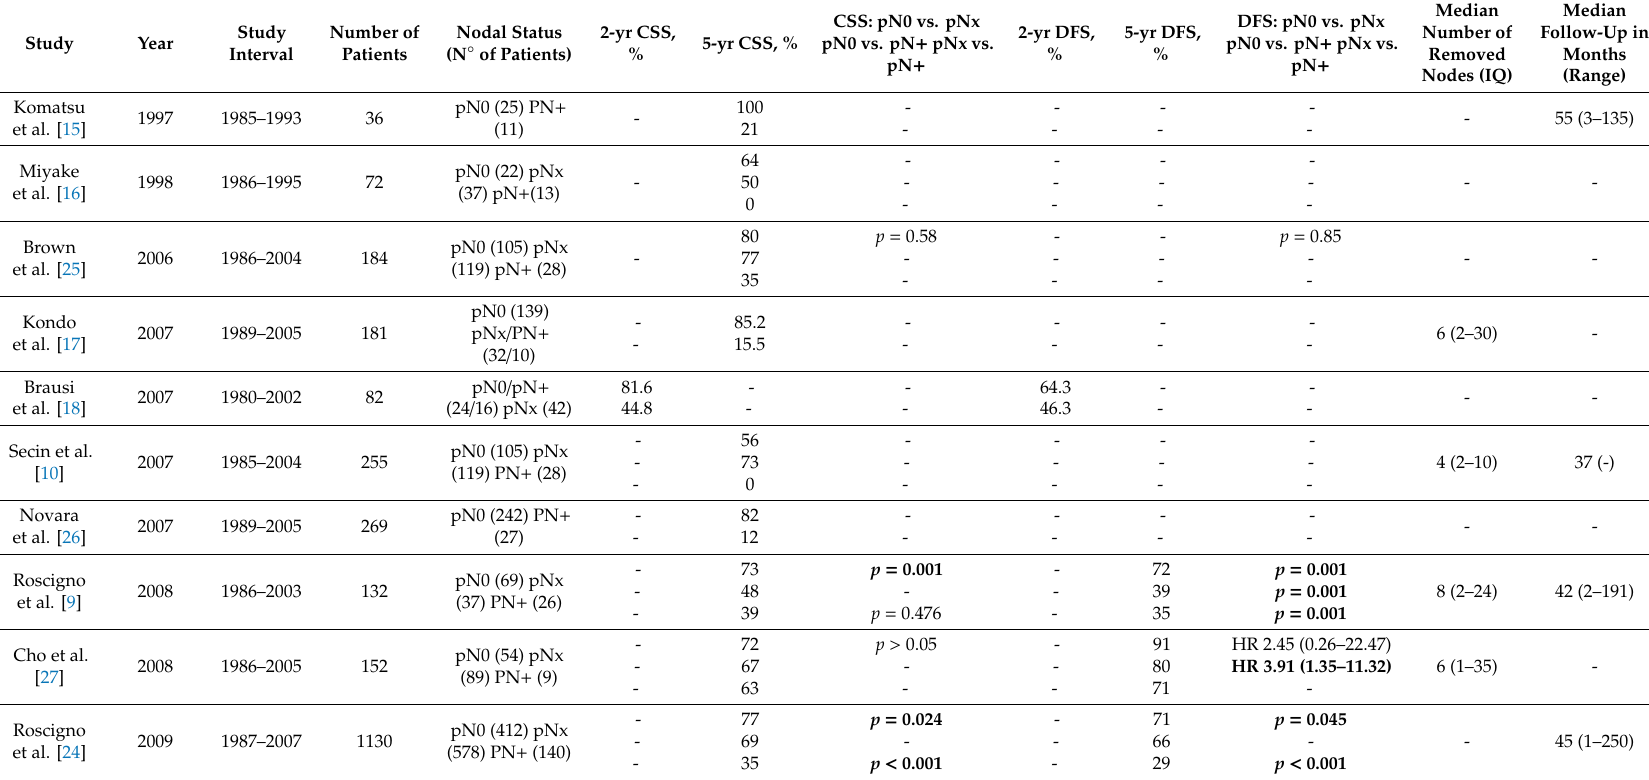
Table 2. Oncological outcomes based on nodal status. The data in bold are statistically